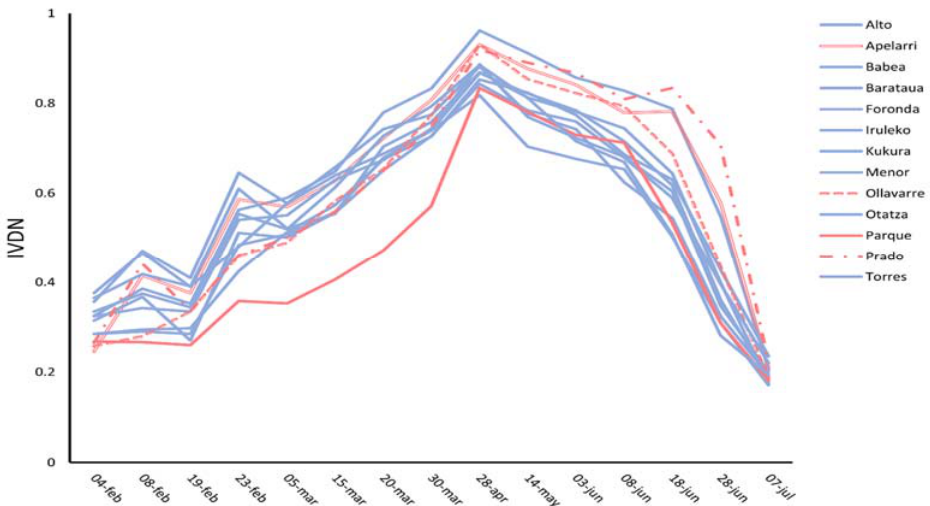
Figure 7. NDVI temporal evolution of the 13 plots. Blue color shows the plots that have reached a moderate level of agreement (related plots) between NDVI and yield. Pink color shows the group of plots that did not reach a moderate agreement (unrelated plots). The plots belonging to this group have been individually identified with different types of lines.